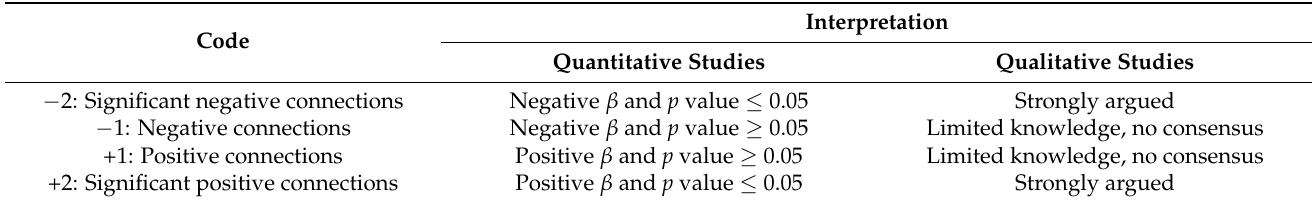
Table 2. Assessment of votes based on described